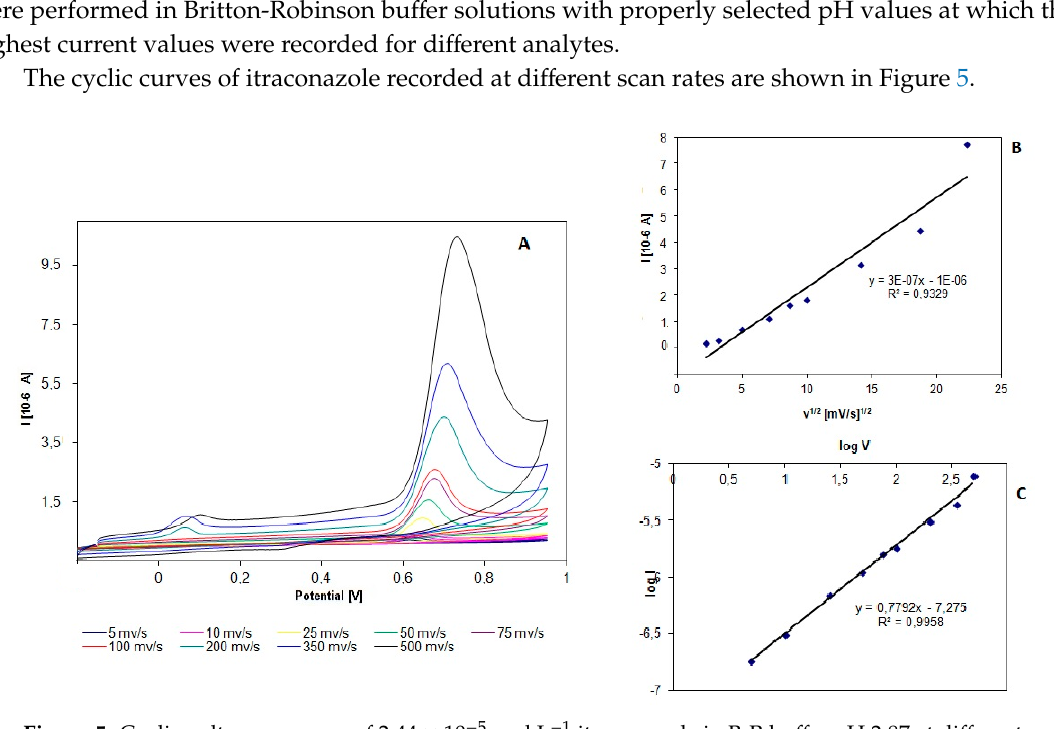
Figure 5. Cyclic voltammograms of 2.44 × 10 − 5 mol·L − 1 itraconazole in B-R buffer pH 2.87 at different scan influence of interferents rates ( A ); the dependence of I p on the square root of scan rate ( B ); and the plot for dependence of log I p on log of scan rate ( C ).